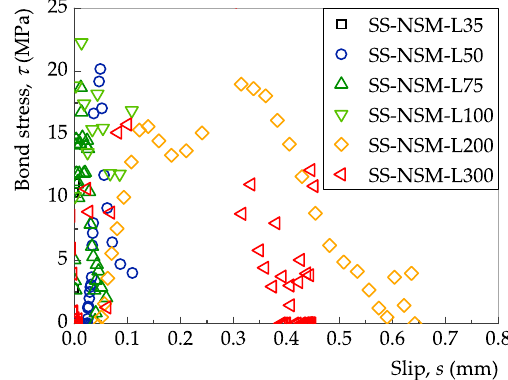
Fig. 14 Interfacial bond–slip relationships obtained for the NSM